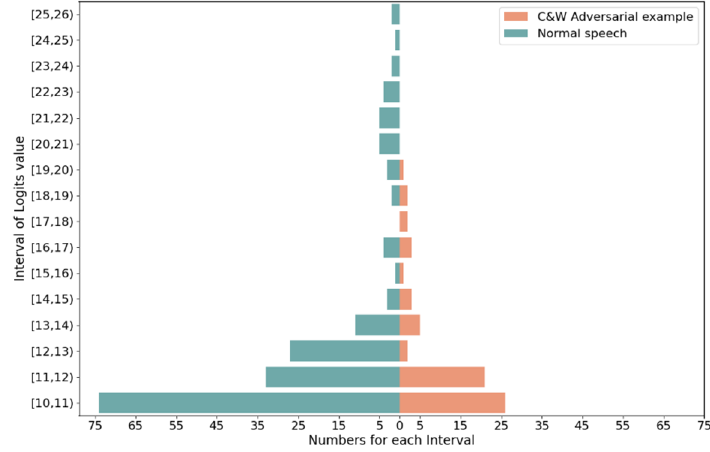
Figure 6. Logits value statistics in Lingvo.